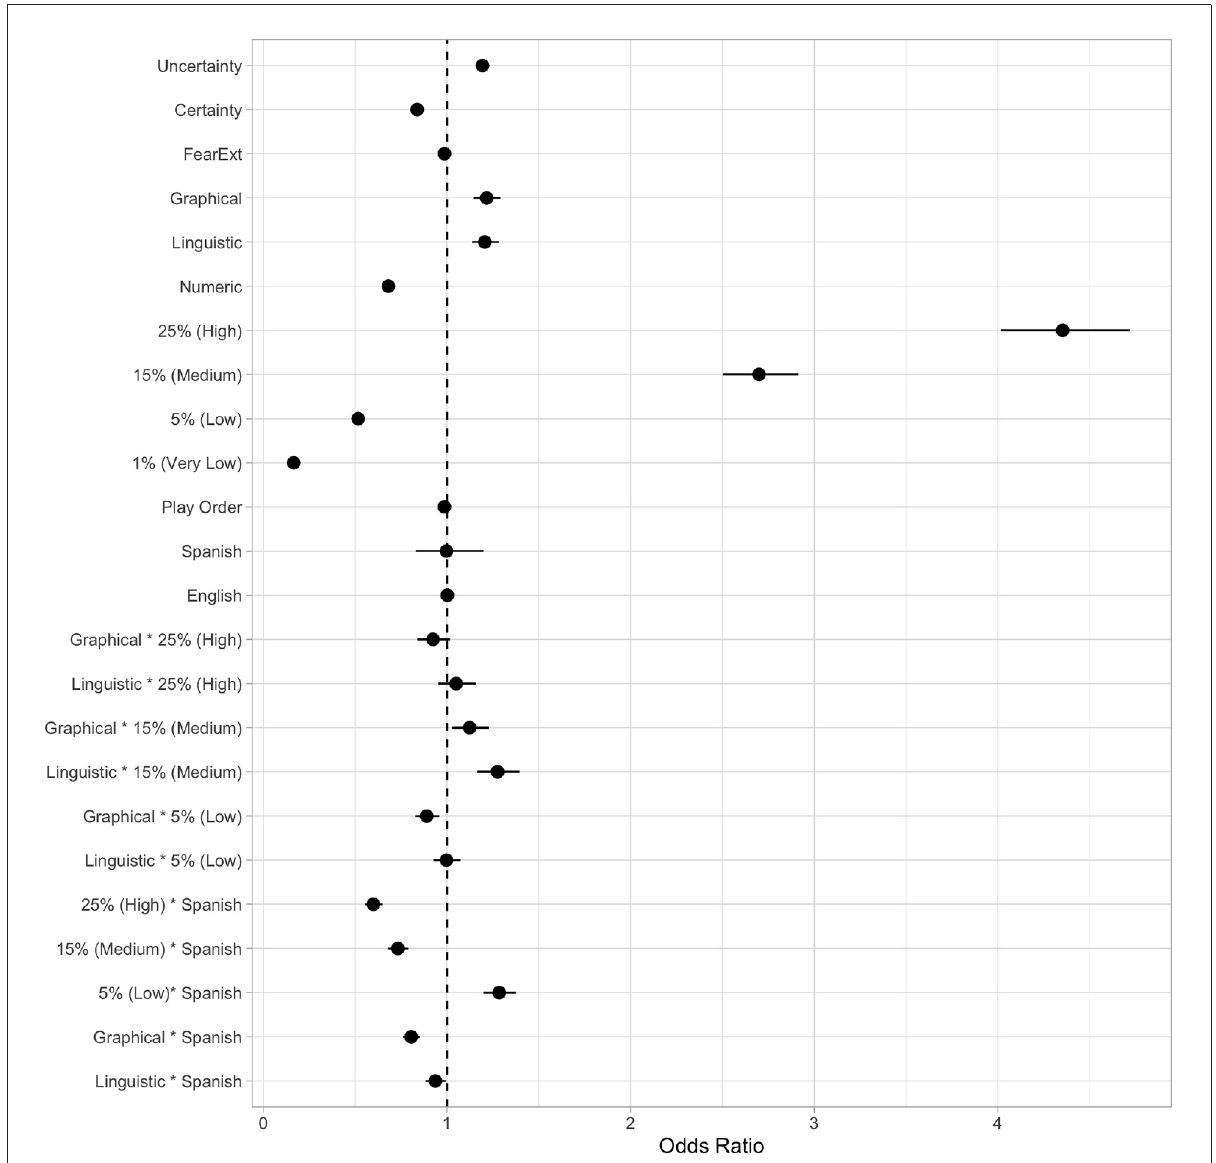
FIGURE4 Odds ratio and 95% confidence interval of complying with the shower practice over grand mean. For categorical variables, the reference levels are certainty messaging, numeric messaging, 1% (very low), and English and they are coded as − 1 in the model. For categorical variables with more than two levels, it compares each level with the reference level. For example, numeric messaging ( − 1), linguistic messaging (0), and graphical messaging (1). The asterisk (*) denotes interactions among the variables that it